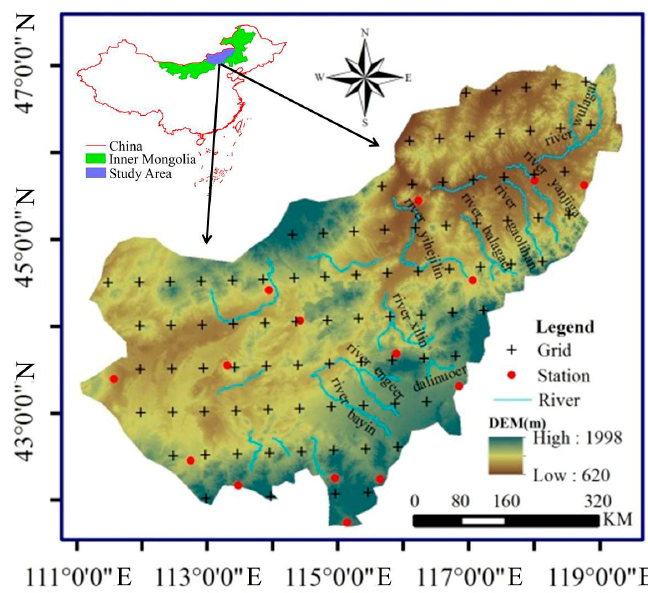
Figure 1. Distribution of inland rivers, weather stations, and 0.5° × 0.5° grid points.